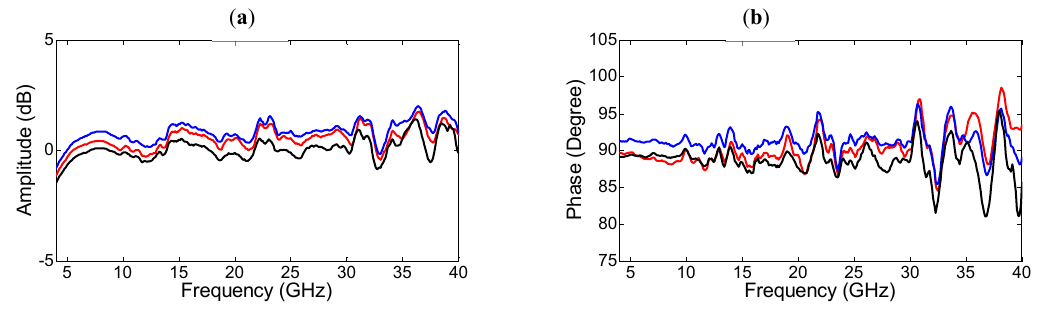
Figure 10. ( a ) The amplitude and ( b ) phase responses of three 4 to 40 GHz bandwidth 90 ◦ hybrid couplers measured at the coupler 90 ◦ output port with reference to the coupler 0 ◦ output port.